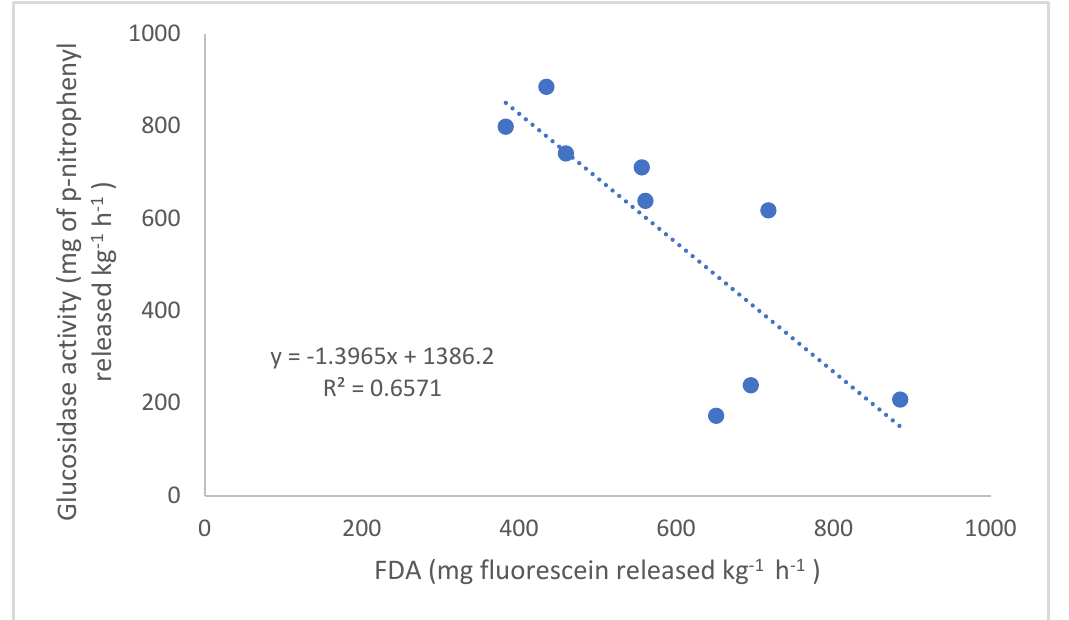
Figure 1. Relationship between the yearly average of fluorescein diacetate hydrolysis and ß -1 ,4-glucosidase from 2014 to 2016 across Becker, Waseca, and Lamberton.